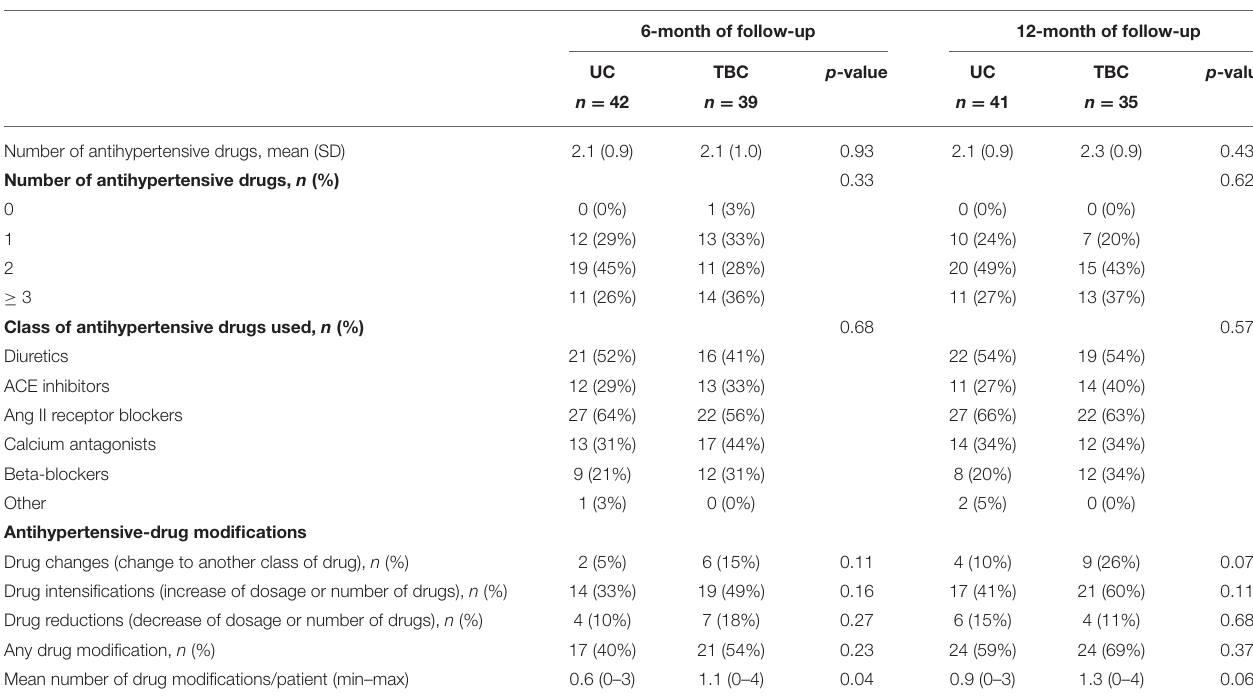
TABLE 4 | Antihypertensive drugs at 6- and 12-month of follow-up.